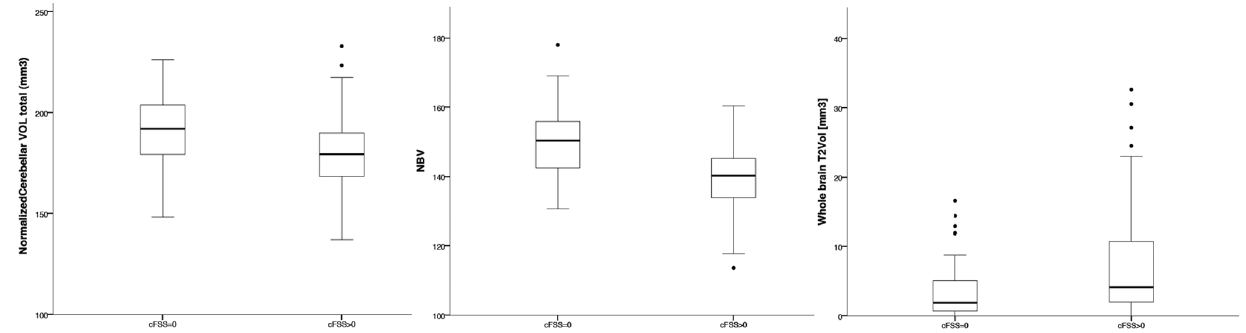
Figure 1. Between group differences. Box and whisker-plots of between-group differences of patients without (cFSS=0; left column) and with cerebellar dysfunction (cFSS . 0; right column). Plots are arranged as follows (from left to right): I) nTCV, II) NBV and III) whole brain T2 lesion volume (all volumes are shown in cm 3 ). The boxplots display the median (bold line), the minimum (lower T-line) and maximum (upper T-line) as well as the first quartile (lower part of the box) and third quartile (upper part of the box) of shown